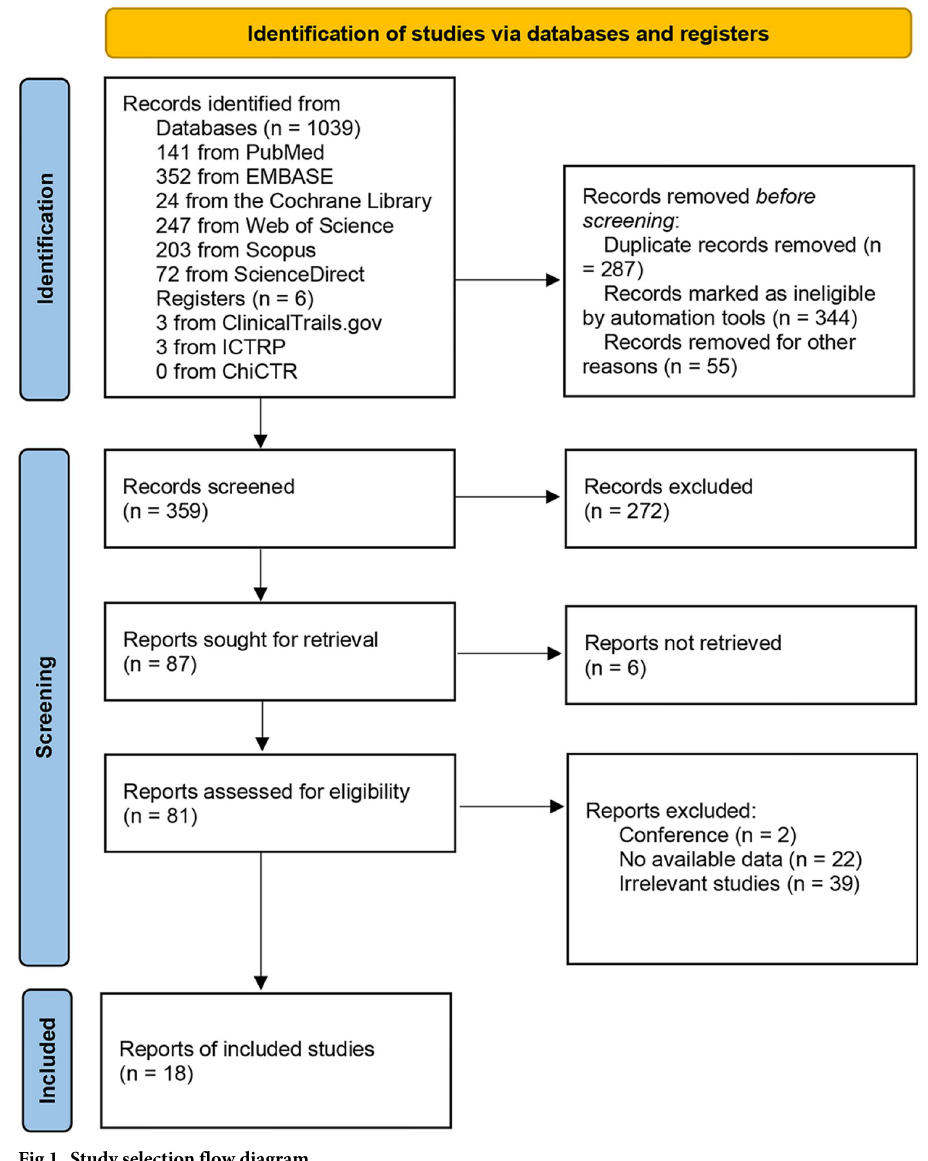
Fig 1. Study selection flow